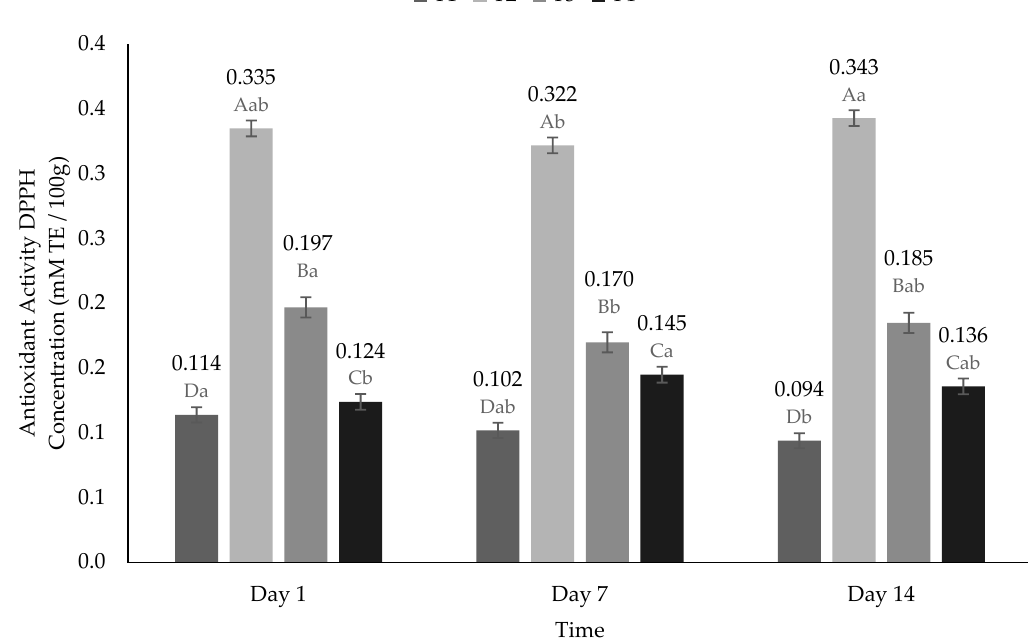
Figure 4. Antioxidant activity (DPPH˙ method) of yogurt added with beet extract. T1 = Natural yogurt (Y), T2 = Y added with beet juice, T3 = Y added with extract encapsulated with Maltodextrin, and T4 = Y added with extract encapsulated with Inulin. A,B,C,D Values with different superscript indicate significant statistical difference between treatments ( p < 0.05). a,b Values with a different superscript indicate significant statistical difference over time ( p < 0.05).